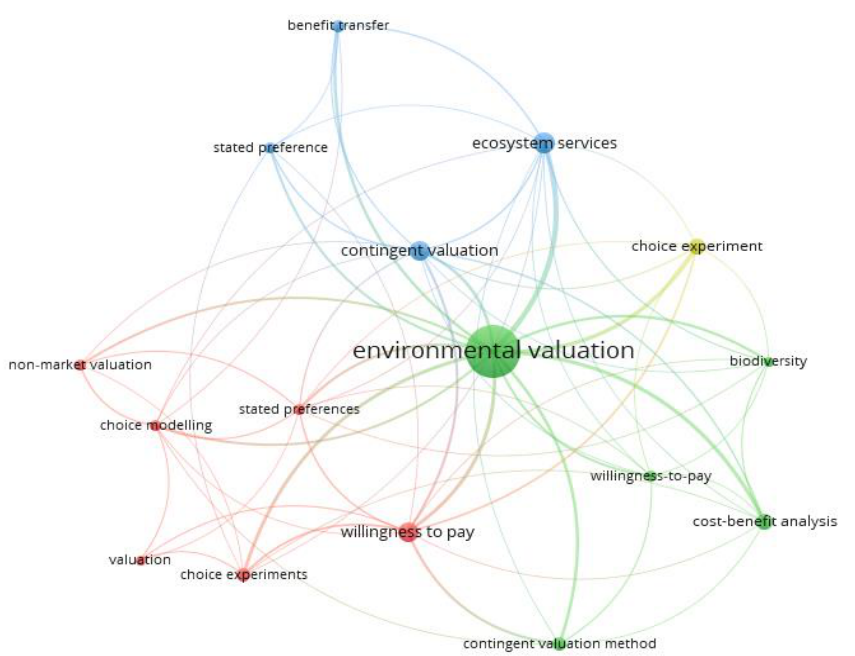
Figure 9. Keyword co-occurrence network visualisation map.